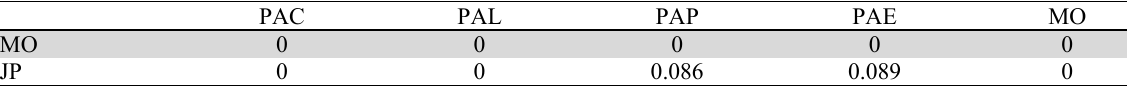
The results of indirect